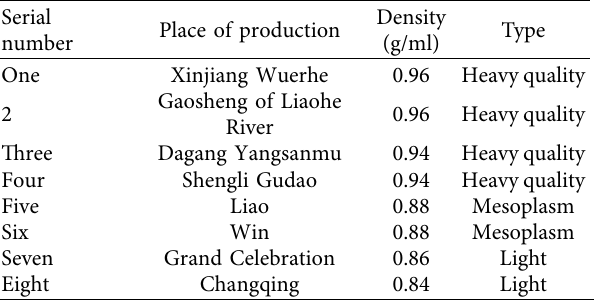
Table 1: Oil density of different producing areas in